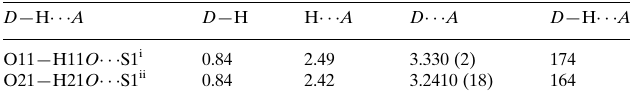
Hydrogen-bond geometry (A ˚ , (cid:3)